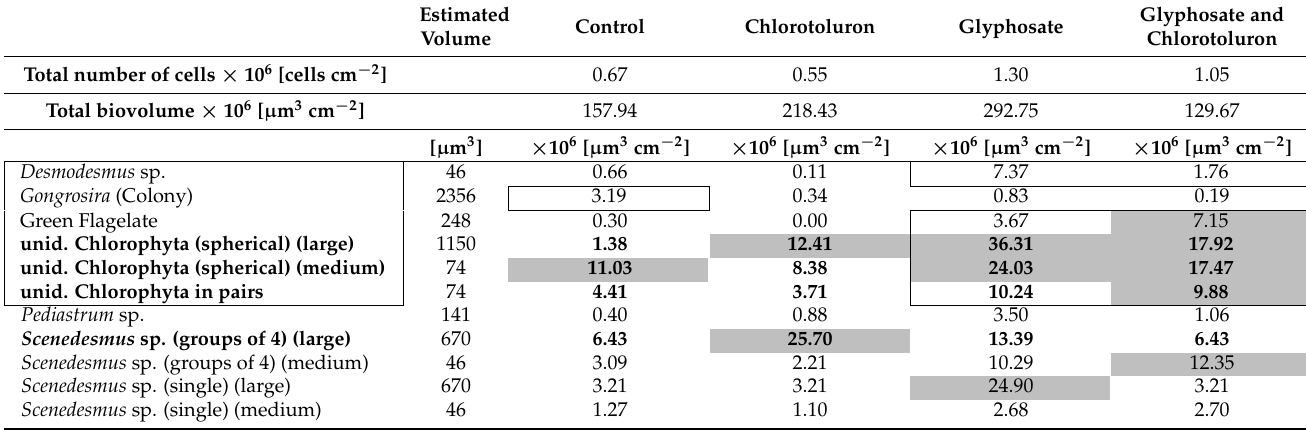
Table A2. Total abundance (as areal density and biovolume) and species abundance (as biovolume) of the Chlorophyta in biofilms for all treatments. Species that contributed >5% to the total biovolume are shown in grey. Species that occurred in high abundance in all treatments are highlighted in bold. Species that were impacted positively or negatively by the herbicide treatments are highlighted with a bold frame. Cyanobacteria were not included due to very low representation. ( n =